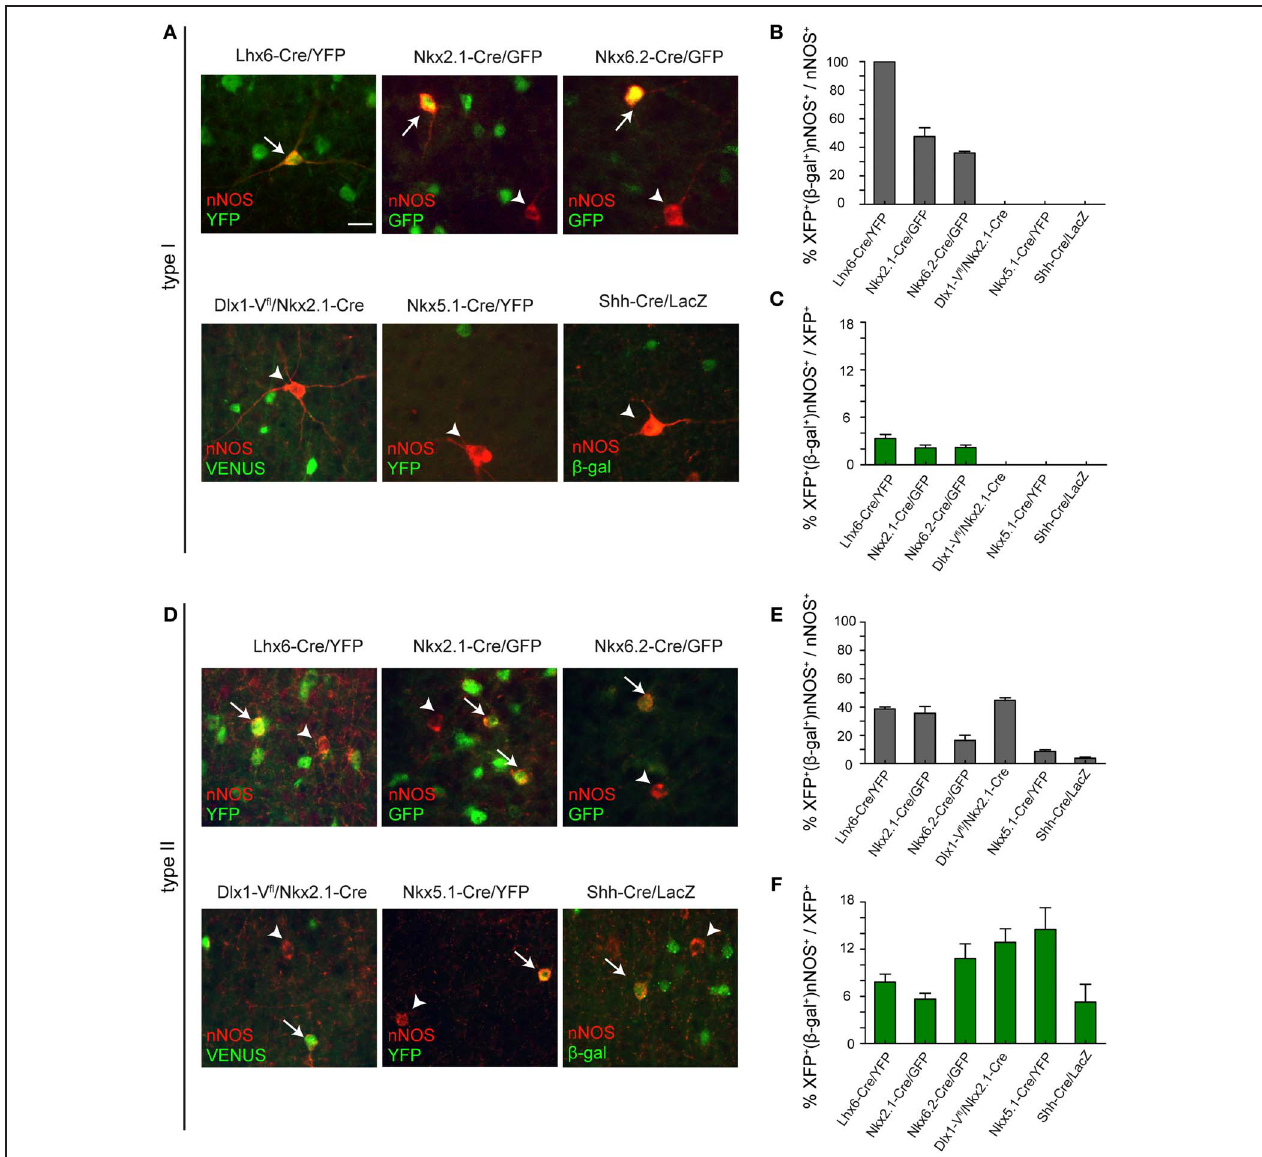
(D) Coexpression of nNOS and GFP/YFP/Venus/ β -gal in type II cells in different transgenic mouse lines. Arrows and arrowheads point to double and single-labeled type II cells, respectively. (E) Contribution of different progenitor pools to type II cells. The extent of co-localization between nNOS and GFP/YFP/Venus/ β -gal in type II cells is shown as a percentage of the total nNOS type II cells ( E ) or as a percentage of the total GFP/YFP/Venus/ β -gal-expressing interneurons (F) . Error bars indicate SEM. Scale bar: 20 μ m. CB, PV, or RLN ( Figure 7 ). Type II cells show some coexpres- sion with all markers examined ( Figure 7 ). Our data confirm the previously described heterogeneity of the nNOS interneuron pop- ulation based on the levels of nNOS expression, morphology, and coexpression of other interneuron markers. Our fate-mapping suggests that this heterogeneity is laid down during embryonic development when these cells are specified from neuroepithelial precursor